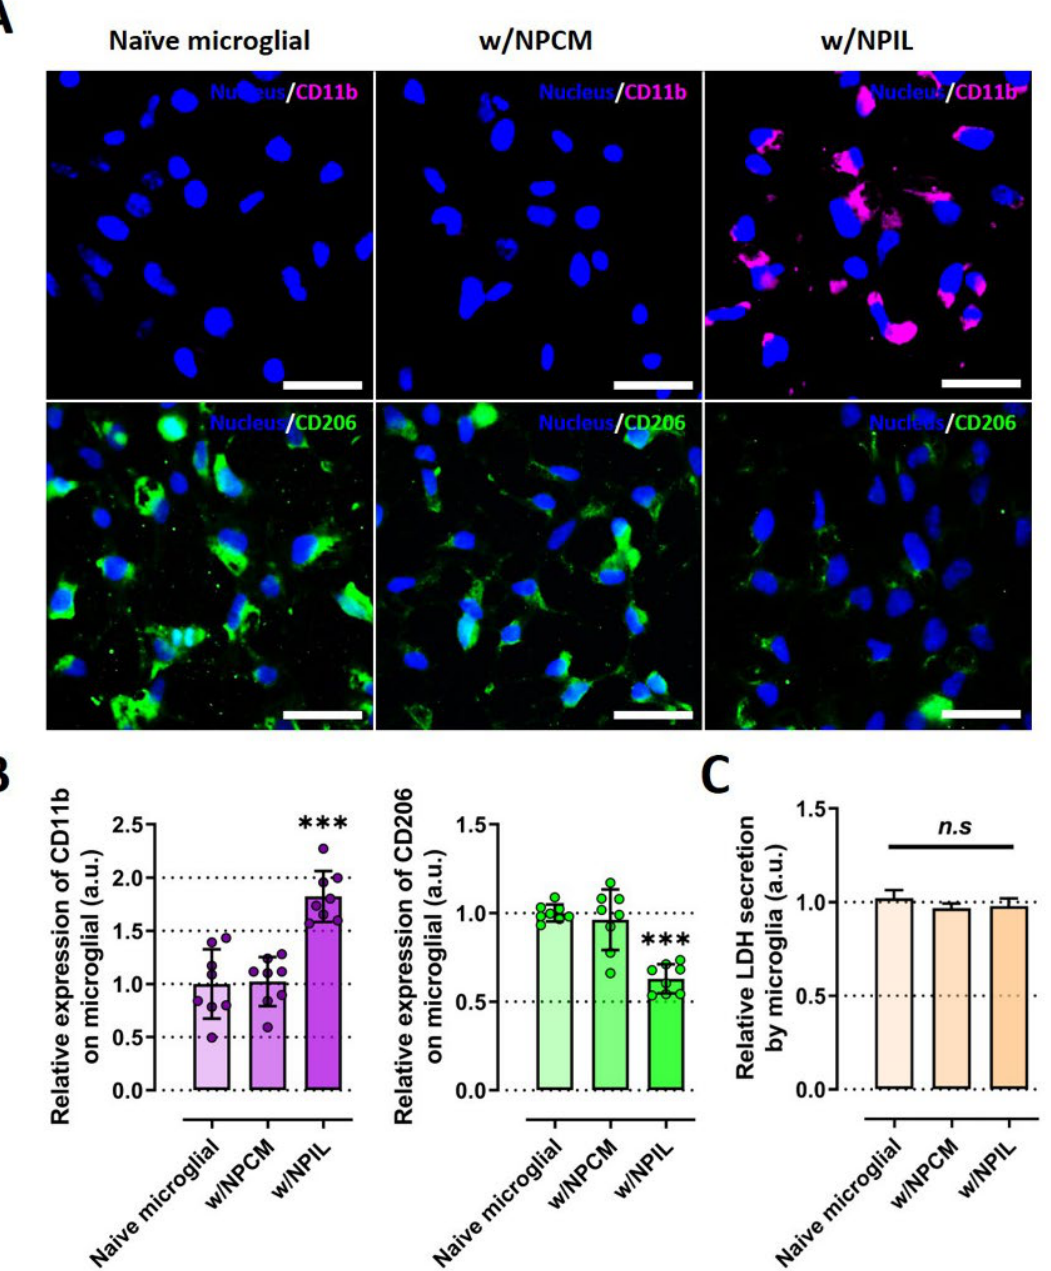
Figure 5. IL-1 β -stimulated human NP cells induce a microglial phenotypic switch to proinflammation. ( A ) Immunofluorescence data revealed condensed CD11b or CD206 expression in the cytoplasm of microglia cultured in NPIL or NPCM compared with naïve microglia, respectively. ( B ) Quantification of the fluorescence intensity of the CD markers in microglia. The results showed the increased expression of CD11b protein (M1 macrophage maker), and the decreased expression of CD206 (M2 macrophage marker), in microglia under the presence of NPIL. ( C ) Assessment of microglial cytotoxicity with NPCM or NPIL by using LDH assay. Microglia cultured in NPCM or NPIL did not exhibit any difference in cell cytotoxicity compared with naive microglia. Scale bars, 50 µ m. *** p < 0.001, and n.s., no significant difference, as compared with naïve microglia. The line indicates the comparison with each group. Each dot represents the mean of six samples in an independent